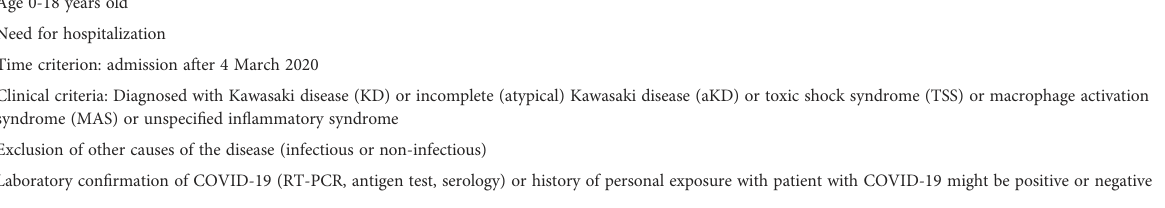
TABLE 1 The Polish inclusion criteria of PIMS/MIS-C